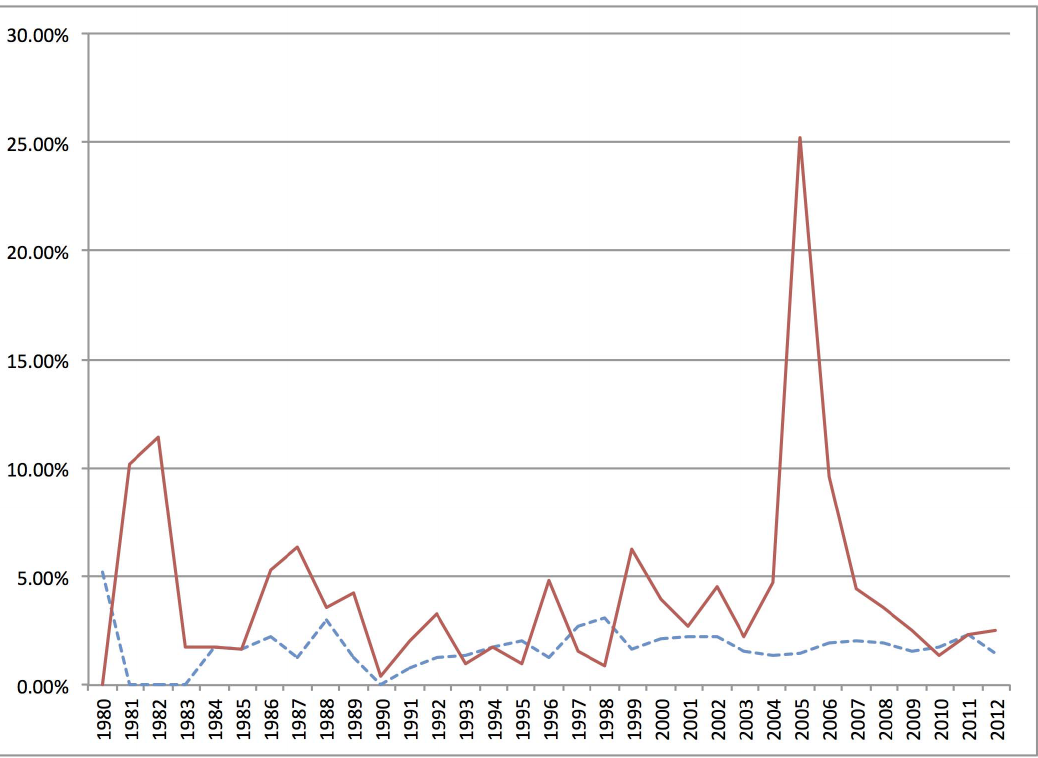
Figure 8. Comparison of prominence of religion (dotted blue) and evolution (solid red) in demarcation corpus over time. Percentage of documents in each year with at least 15% topic content.